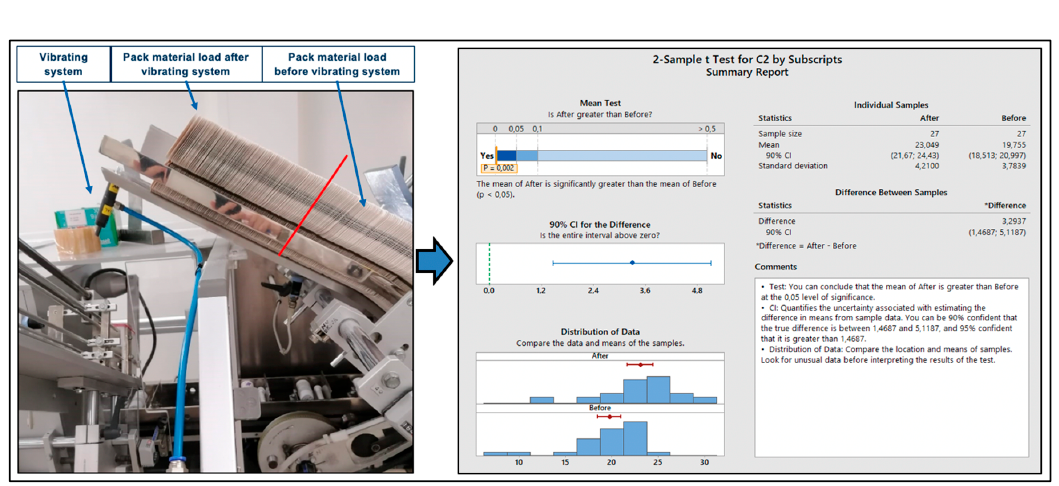
Figure 7. Brainstorming session outcome.